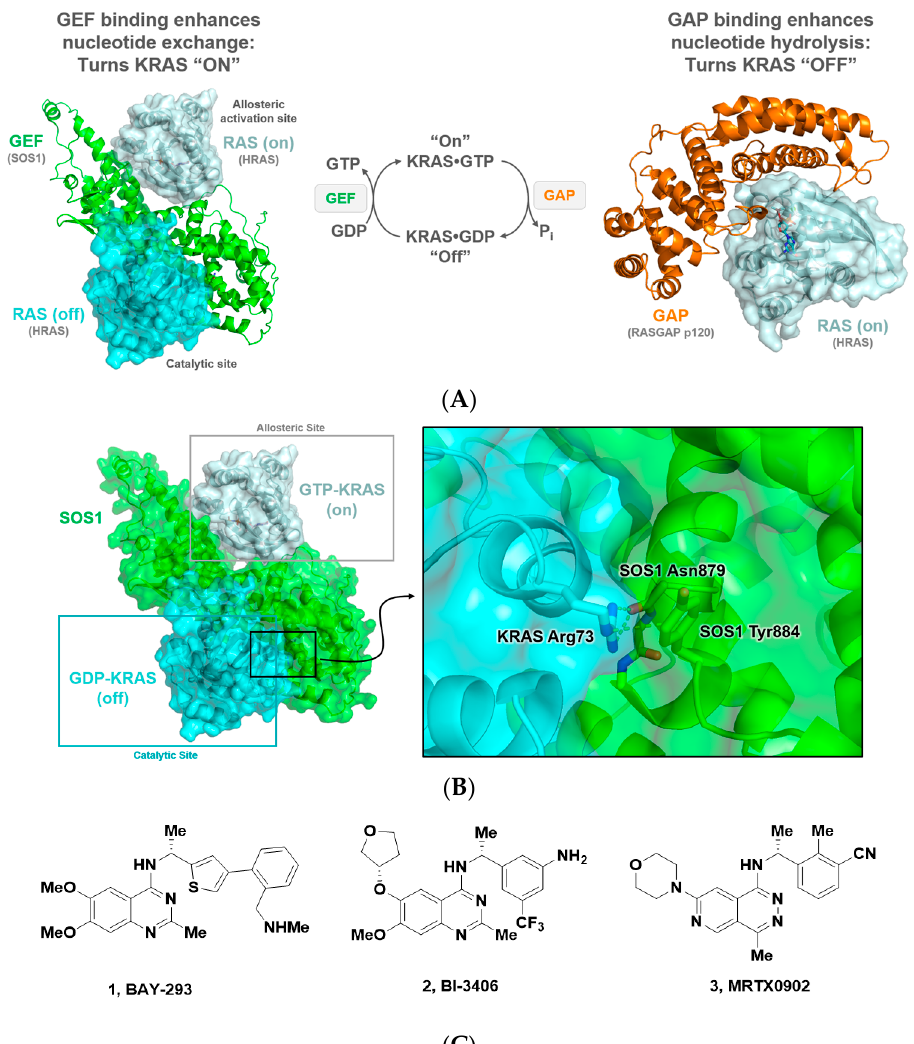
Figure 2. ( A ) Depiction of GEF and GAP activity to convert KRAS between its GDP- and GTP-loaded states. ( B ) SOS1 in green, in cyan GDP-KRAS binding to the catalytic site on SOS1, and in grey GTP-KRAS binding to SOS1 in an allosteric binding site. Key protein–protein interactions between KRAS Arg73 and SOS1 Asn879 and Try884 are highlighted. ( C ) Selected compound structures of SOS1 binders that disrupt the SOS1:RAS PPI including: BAY-293 ( 1 ), BI-3406 ( 2 ), and MRTX0902 ( 3 ).